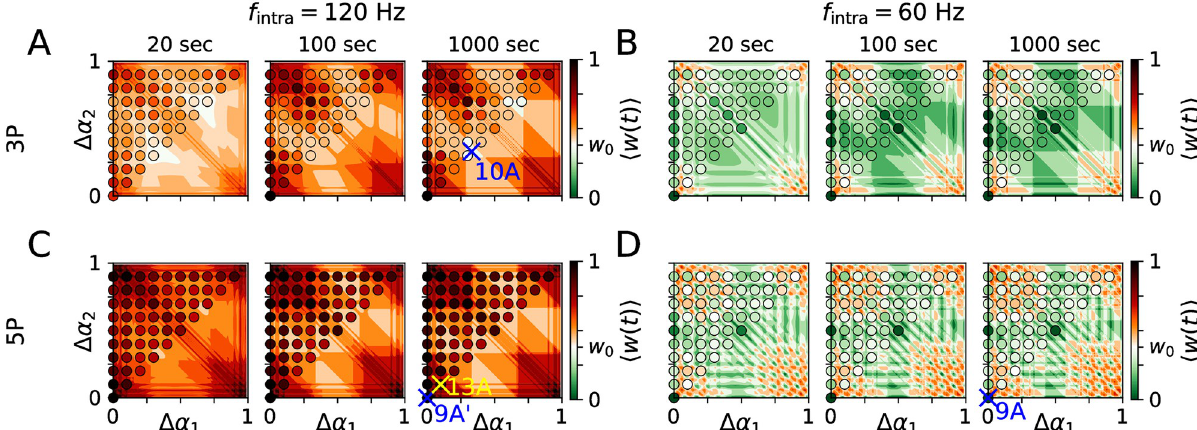
Fig 7. Mean synaptic weight during PMCS with burst stimuli depends on intraburst frequency and number of pulses per burst. Panels A,C and B, D show results for PMCS with burst stimuli with high (120 Hz) and low (60 Hz) intraburst frequencies, respectively. Rows show results for burst stimuli with three (top, 3P) and five (bottom, 5P) pulses, respectively. Columns show the mean synaptic weight 20 sec (left), 100 sec (middle), and 1000 sec (right) after onset of PMCS. Color maps show theoretical predictions, obtained from Eq 4, and filled circles resulted from simulations of the LIF network model. Simulated spike trains, snapshots of the synaptic weight matrix, and corresponding theoretical predictions of the block structure of the synaptic weight matrix, obtained from Eq 1, are shown below for the parameter sets marked by colored crosses (see corresponding figure labels). Parameters: f = 5 Hz, A stim = 0.8, d e =